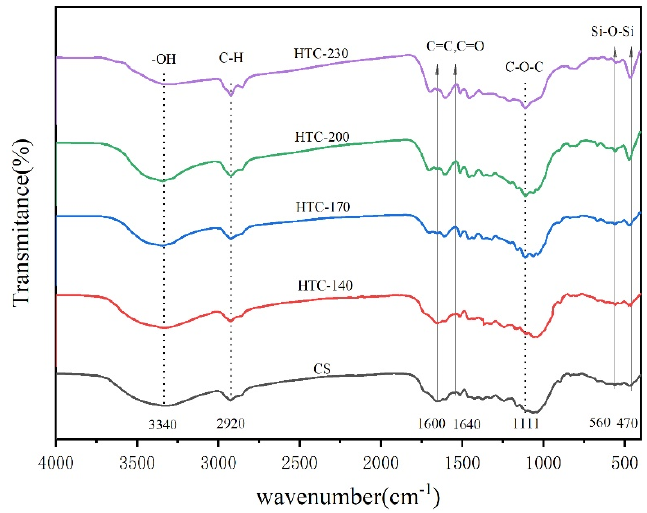
Figure 5. FTIR spectra of CS and hydrochar at different temperatures.